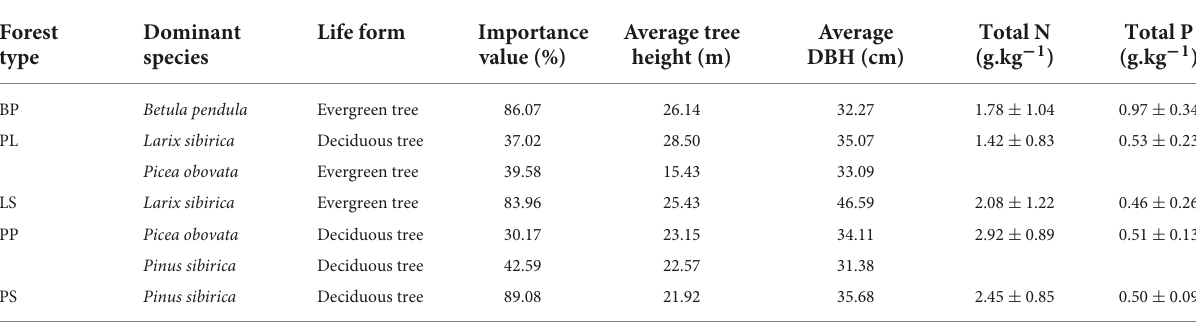
TABLE 1 Basic characteristics of sample